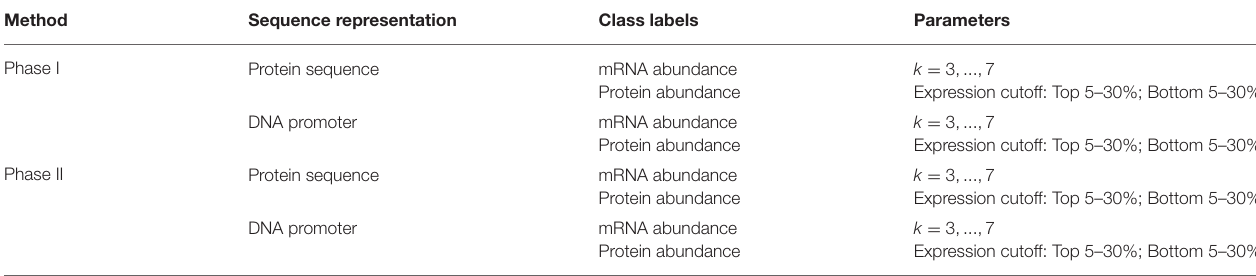
TABLE 2 | A table of the eight experiment types used in this paper.